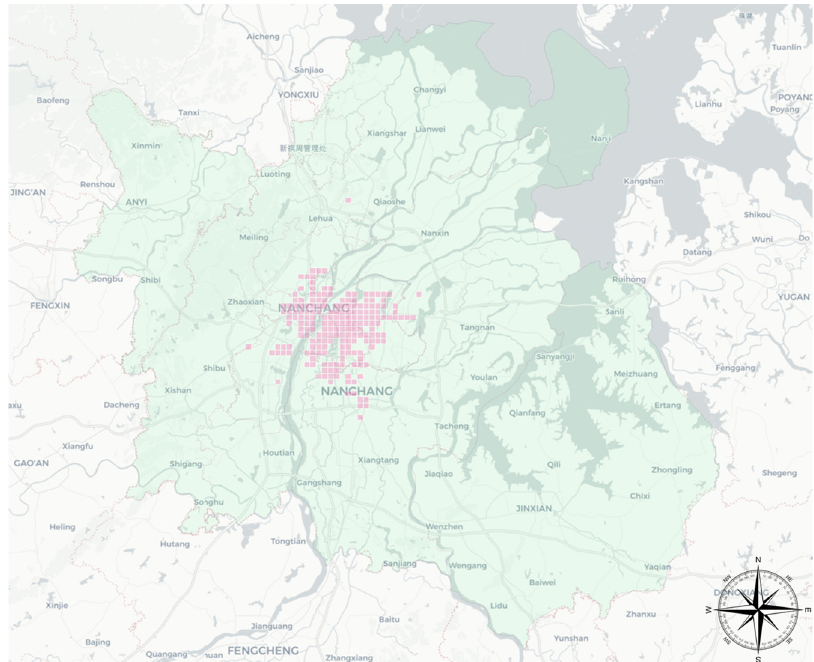
Figure 3. Study area in Nanchang.